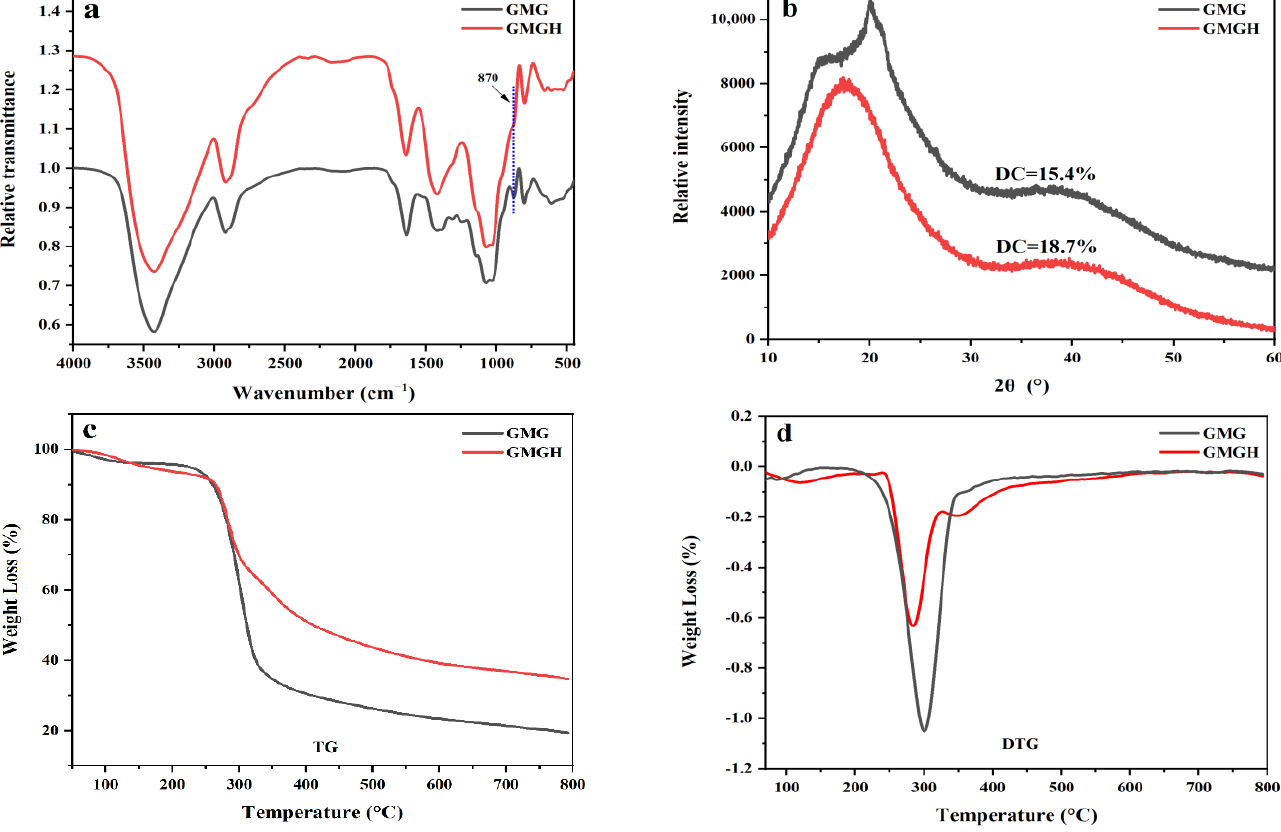
Figure 2. ( a ) FT-IR spectra of the GMG and GMGH powders; ( b ) X-ray diffraction patterns of GMG and GMGH; ( c , d ) thermogravimetric analysis of the GMG and GMGH powders.